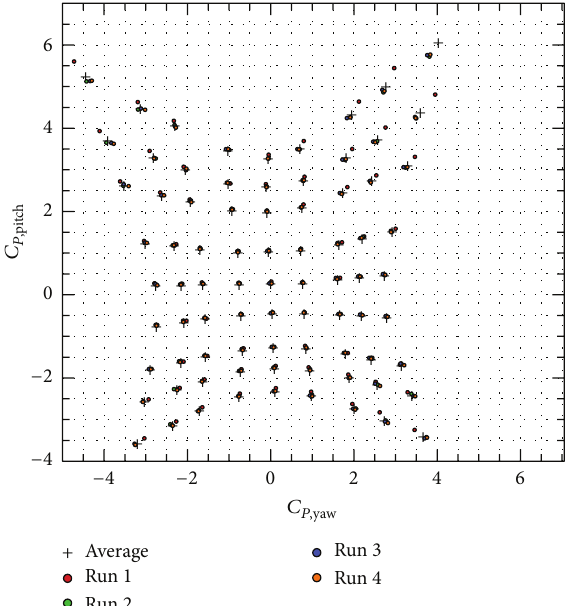
Figure 7: Average values (crosses) with data spread of four runs (points).